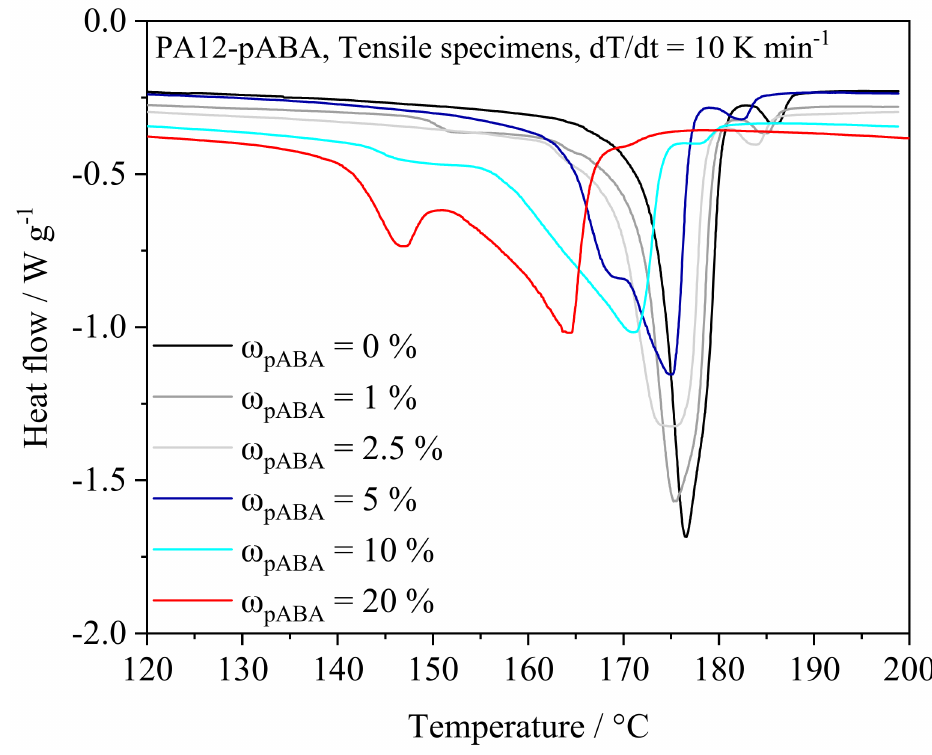
Figure 8. Thermal properties of manufactured tensile specimens assessed using differential scanning calorimetry, n =